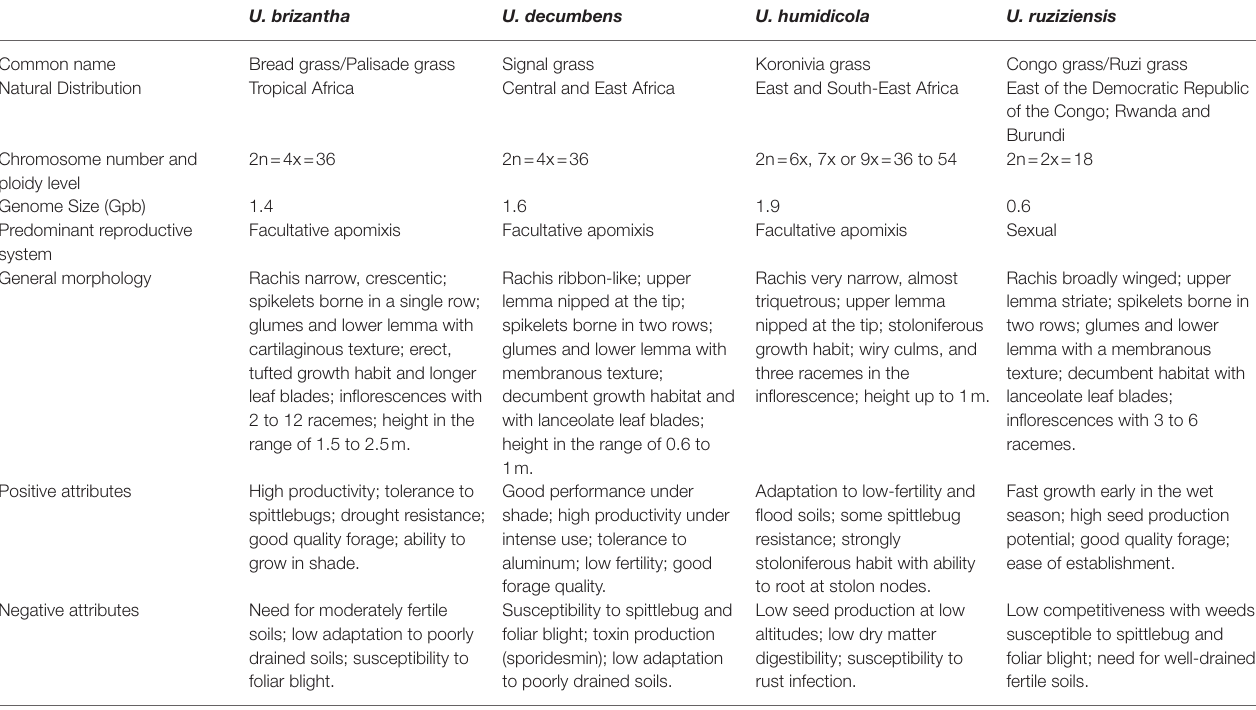
TABLE 2 | General characteristics of the main species of Urochloa used in